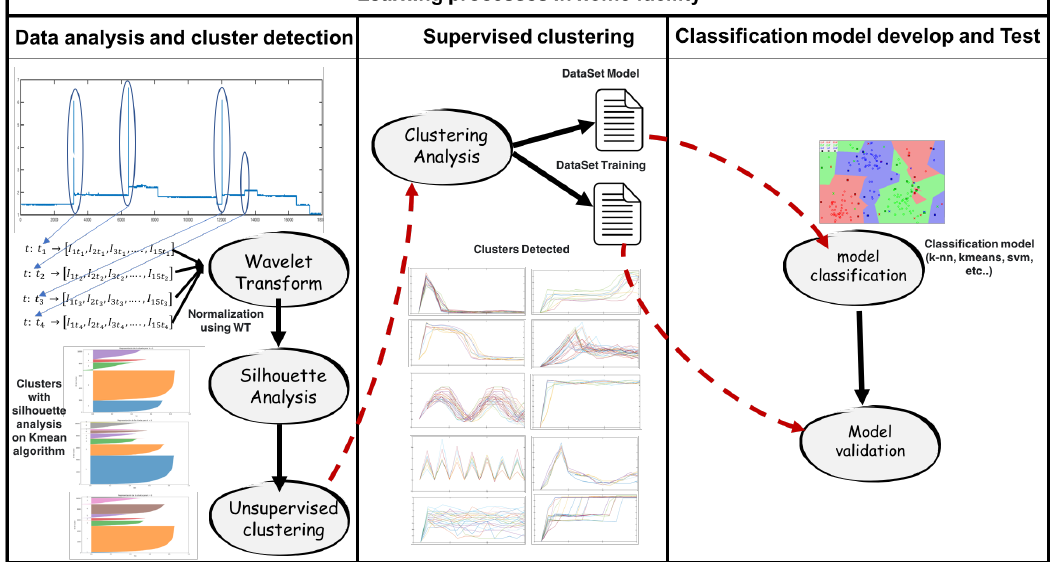
Figure 13. Learning process for classification in the home facility. Silhouette analysis and clusters detected in the experimental home show different phases of the learning